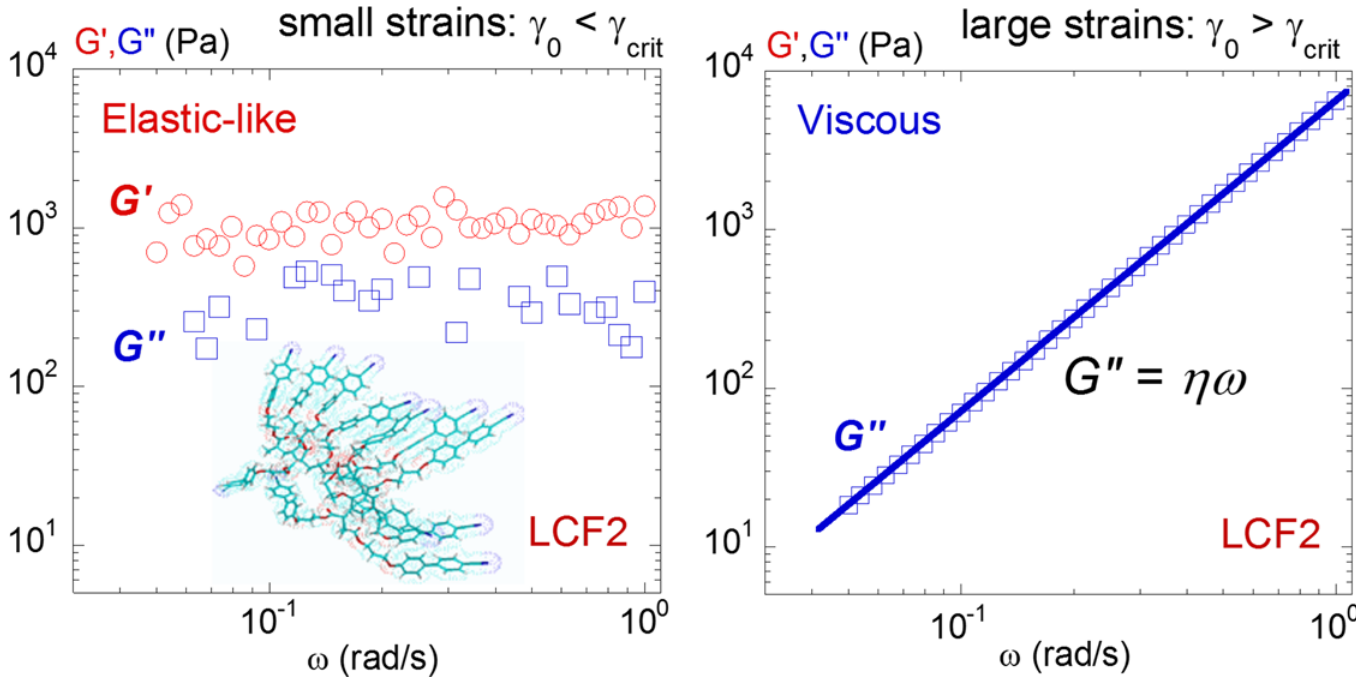
Fig 7. Elastic-like versus viscoelastic relaxation spectra of LCF1: (left) At small strains ( γ 0 = 1.0%) the dynamic response of the LCF1 is similar to LCF2. The elastic modulus G ’ (red circles, (cid:5) ) dominates the viscous modulus G ” (blue squares, □ ) both being independent of the frequency indicating an elastic-like behaviour [3]. (right) At large strains ( γ 0 = 100%) the viscous modulus shows a conventional behaviour (G ” = ω . η ) and reveals a viscoelastic behaviour. Measurements carried out at +6°C above the isotropic-nematic transition, a gap thickness: 200 μ m.